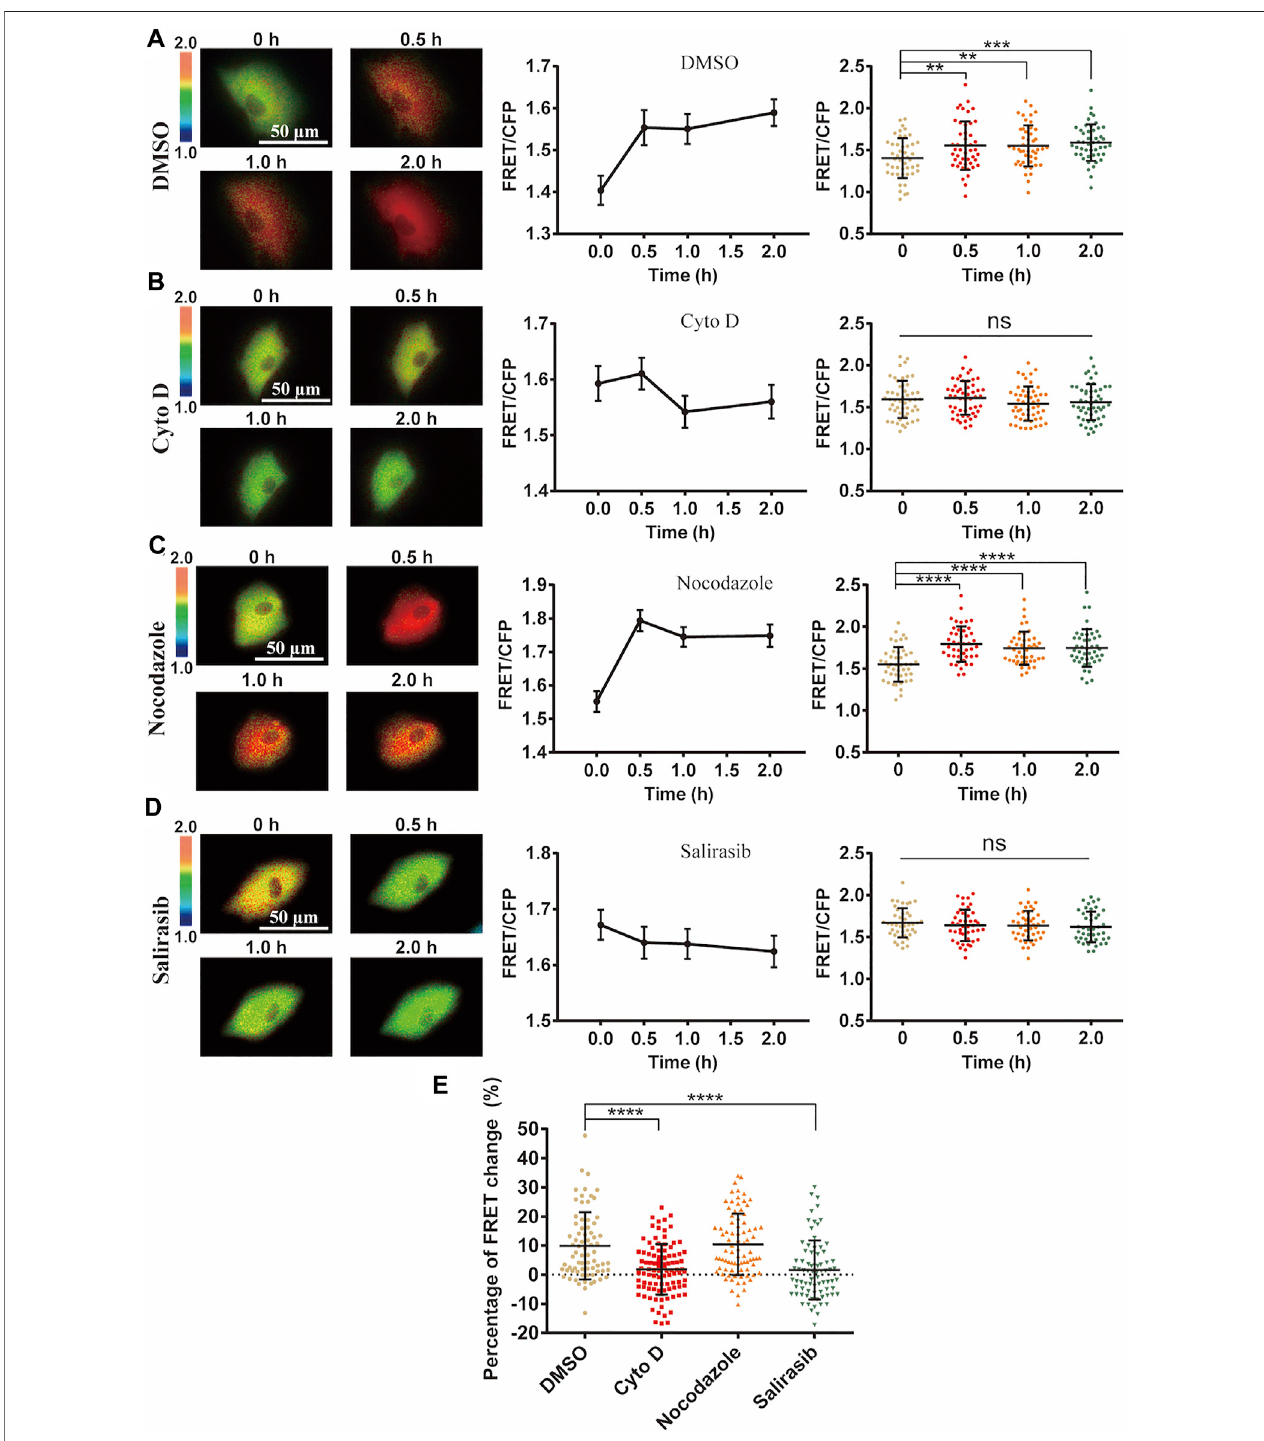
FIGURE 5 | Role of cell cytoskeleton on cyclic stretch-induced ERK activation. ASM cells were pretreated with cytoskeleton or Ras inhibitors, followed by cyclic stretch and imaging. FRET ratiometric images along with change quanti fi cations are shown for each condition before and after cyclic stretch. (A – D) ERK FRET ratiometric images and statistical quanti fi cations of FRET changes in ASM cells pretreated with DMSO ( n = 47) (A) , 1 μ M Cyto D (N = 51) (B) , 1 μ M Nocodazole ( n = 45) (C) , and 75 µM Ras inhibitor Salirasib ( n = 43) (D) . (E) Statistical comparisons of FRET percentage changes in ASM cells pre-treated with DMSO, Cyto D, Nocodazole,andSalirasib( n =73,99,82,77) (A – D) beforeandafter 0.5 hcyclicstretch,basedonimage datafromtwoindependentexperiments.Student ’ st-testwas performed between the control and one experimental group.